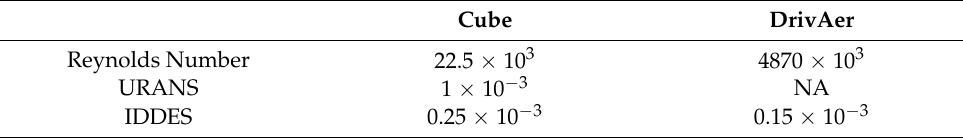
Table 1. Time-step used for each case in